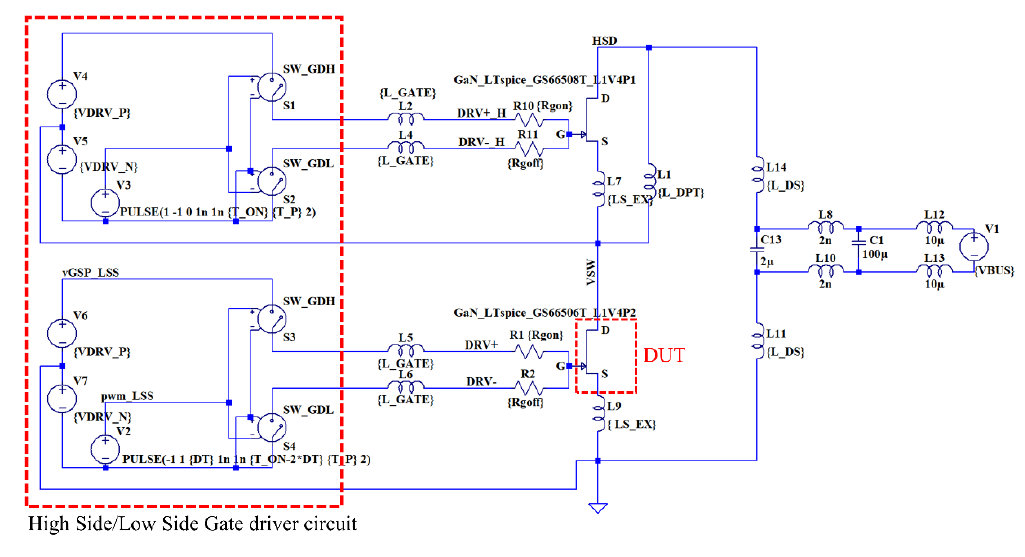
Figure 7. Double-pulse test circuit in LTSpice simulation.